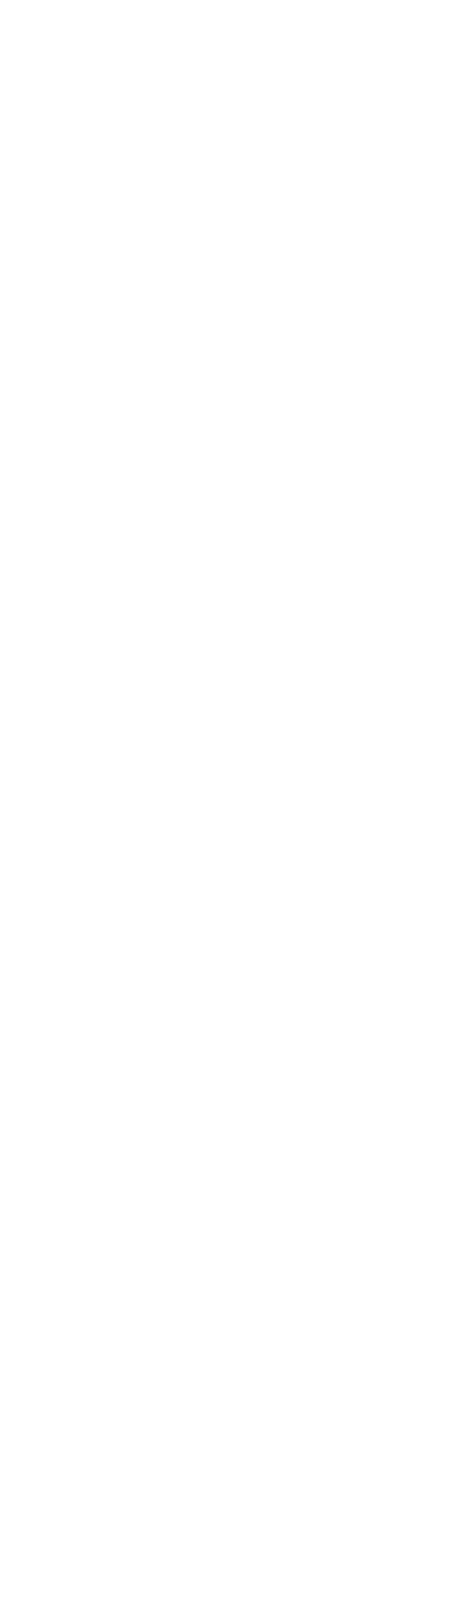
TABLE 1A | The Wald test results for selecting response measurement model.